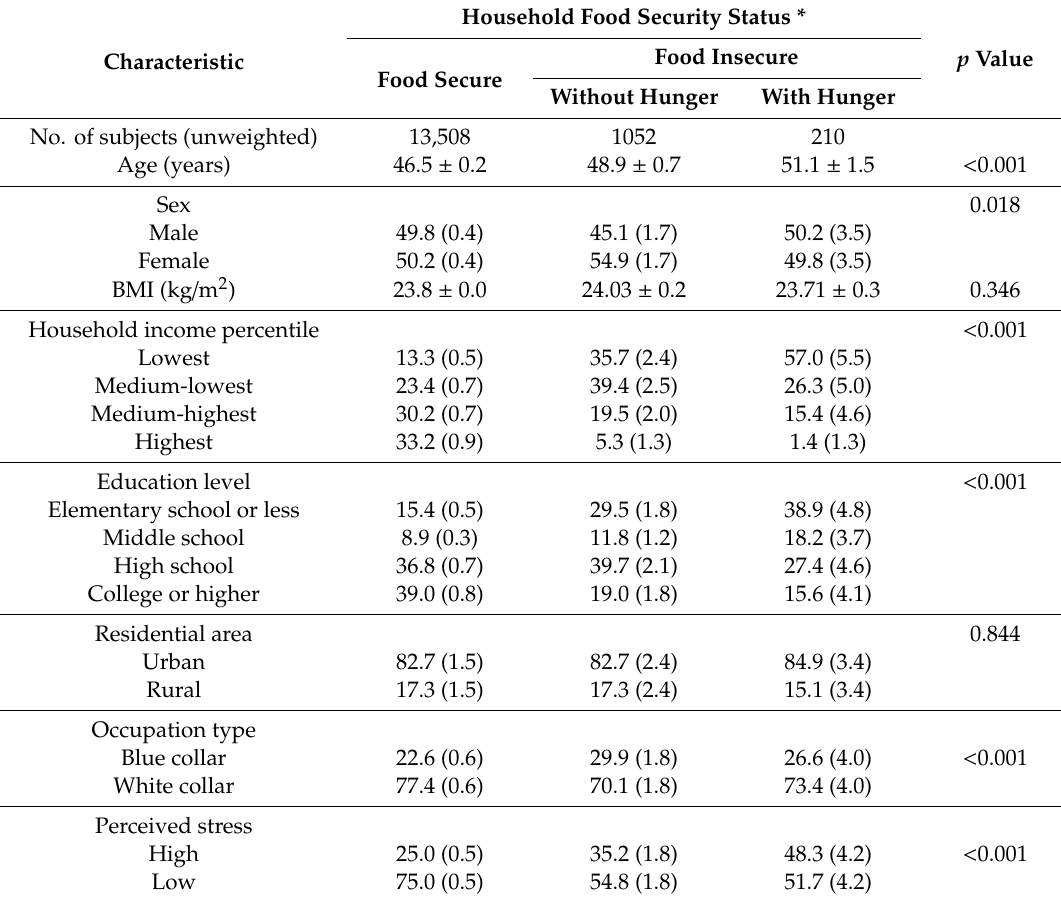
Table 2. Clinical characteristics according to the household food security status in Korean